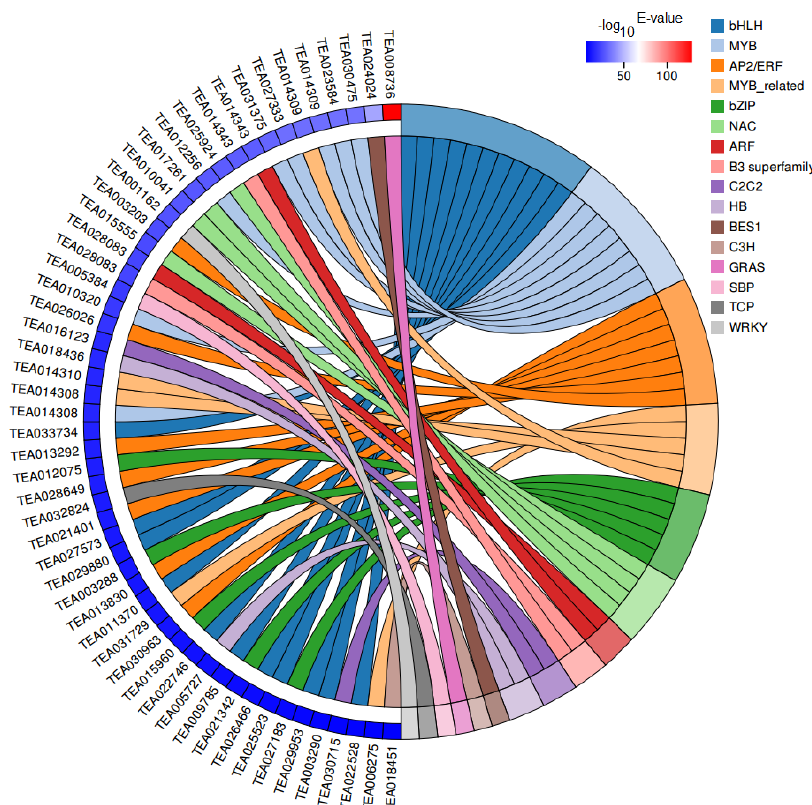
Figure 8. Chord plot of differentially expressed transcription factors (DETFs). Chords show a detailed relationship between the –log 10 E-value of DETFs (left semicircle) and their assigned transcription factor families (right semicircle).